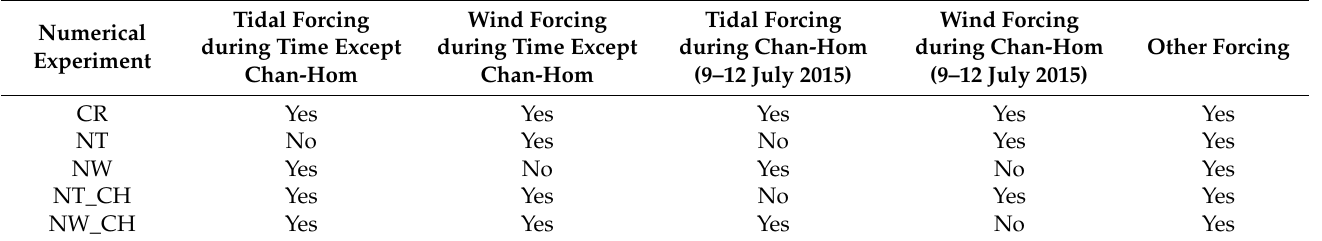
Table 1. Model configurations for the five numerical experiments using the